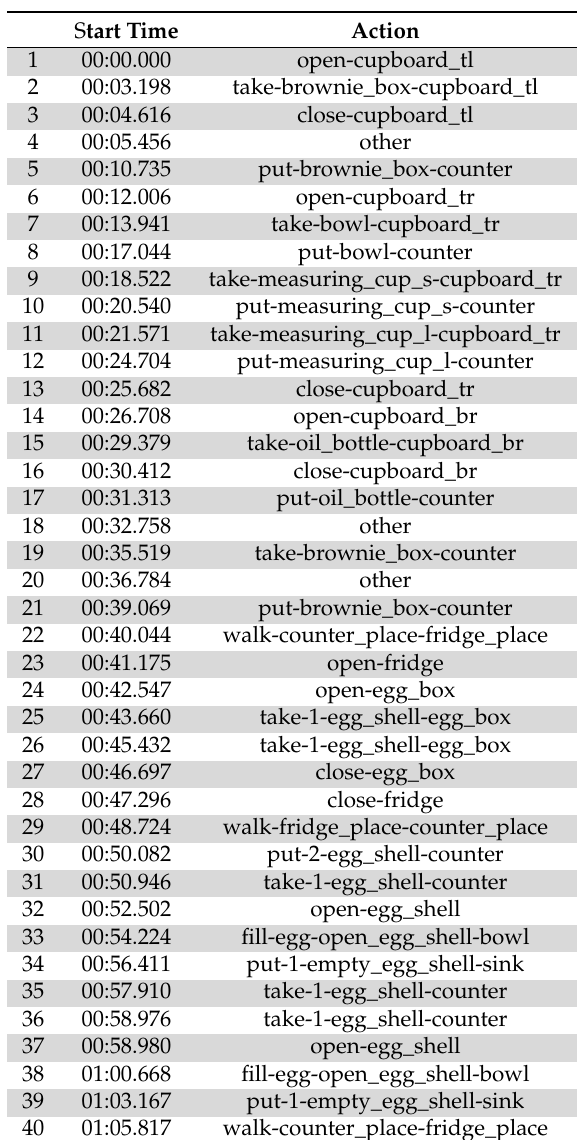
Table 5. Extract of the annotated plan from the Brownie dataset of subject S09. The overall number of actions is